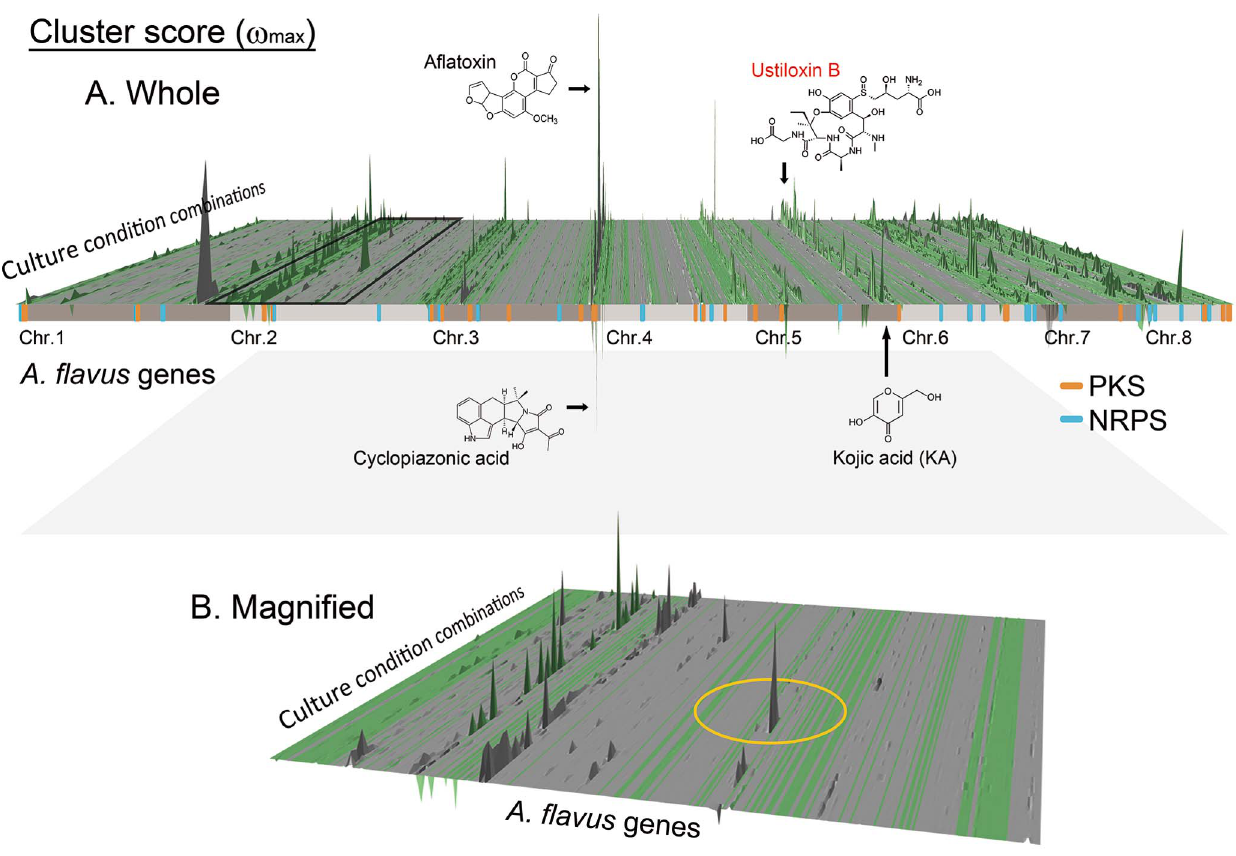
Figure 4. SMB gene cluster detection by MIDDAS-M in A.flavus . (A) A 3D view of the v max scores for all genes and combinations of culture conditions. Comprehensive detection of SMB gene clusters was performed on all 378 pairwise combinations of culture conditions from 28 transcriptomes. The gray and green areas denote blocks of synteny and non-synteny, respectively, with the A. nidulans genome. The positions of gene clusters possessing PKS and NRPS core genes predicted by SMURF are shown in orange and blue, respectively. The chemical structures of four A. flavus secondary metabolites are shown at the positions of corresponding SMB gene clusters; the ustiloxin B gene cluster was first identified in this paper. (B) Magnified view of the area on chromosome 2 corresponding to the black square in A. As an example, a yellow circle designates the peak observed specifically at particular positions, from which conditions for producing the corresponding compound were determined.